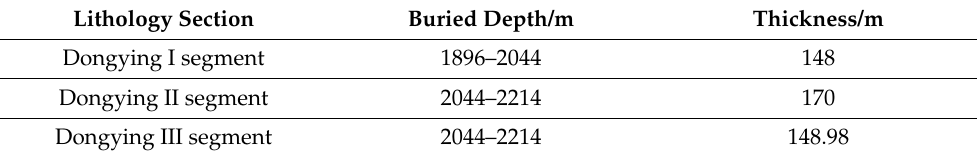
Table 1. The buried depth and thickness of the three Dongying lithology sections.